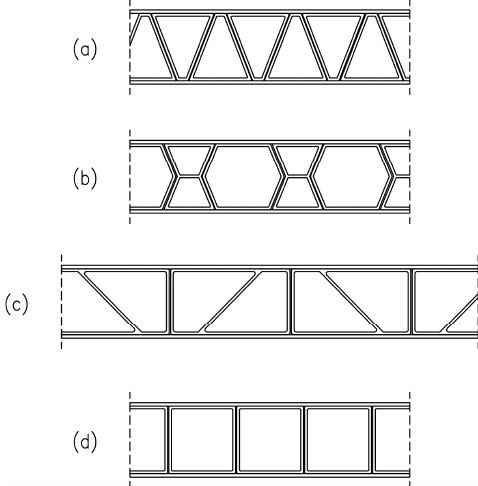
Figure 4. Examples of bridge decks made of adhesively bonded pultruded profiles: ( a ) EZ-Span, ( b ) Superdeck, ( c ) DuraSpan, ( d ) Strongwell FRP Deck System; from [44].